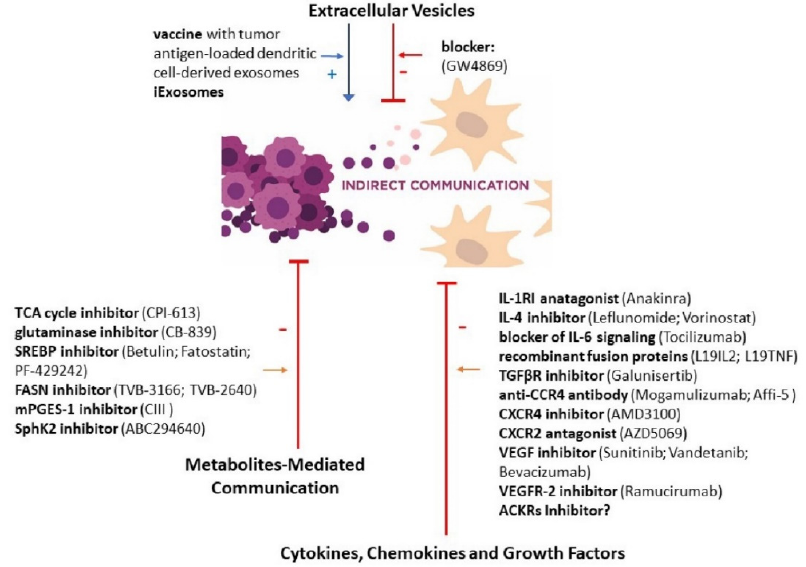
Figure 4. New therapeutic actions targeted at indirect communication in the cancer microenvironment. Two ways of therapeutic options are being considered: the first is focused on attenuation or inhibition of cell–cell interaction (red lines), and the second is based on its intensification for efficient delivery of the drug to tumor cells (blue arrows). ACKR—atypical chemokine receptor; iExosomes—exosomes derived from mesenchymal stromal cells with KrasG12D siRNA; FASN—fatty acid synthase; mPGES-1—microsomal prostaglandin E synthase-1; SphK2—sphingosine kinase 2; SREBP—sterol regulatory element-binding protein; TCA—tricarboxylic acid cycle.